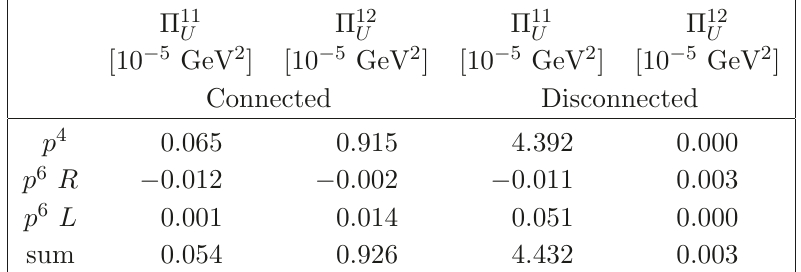
Table 2 . The finite volume corrections to the components of Π µν connected part with q = (0 , 0 , 0 , 0) and a partially twisted up quark with twist angle θ = (0 , π/ 2 , π/ 2 , π/ 2). Note the difference with table